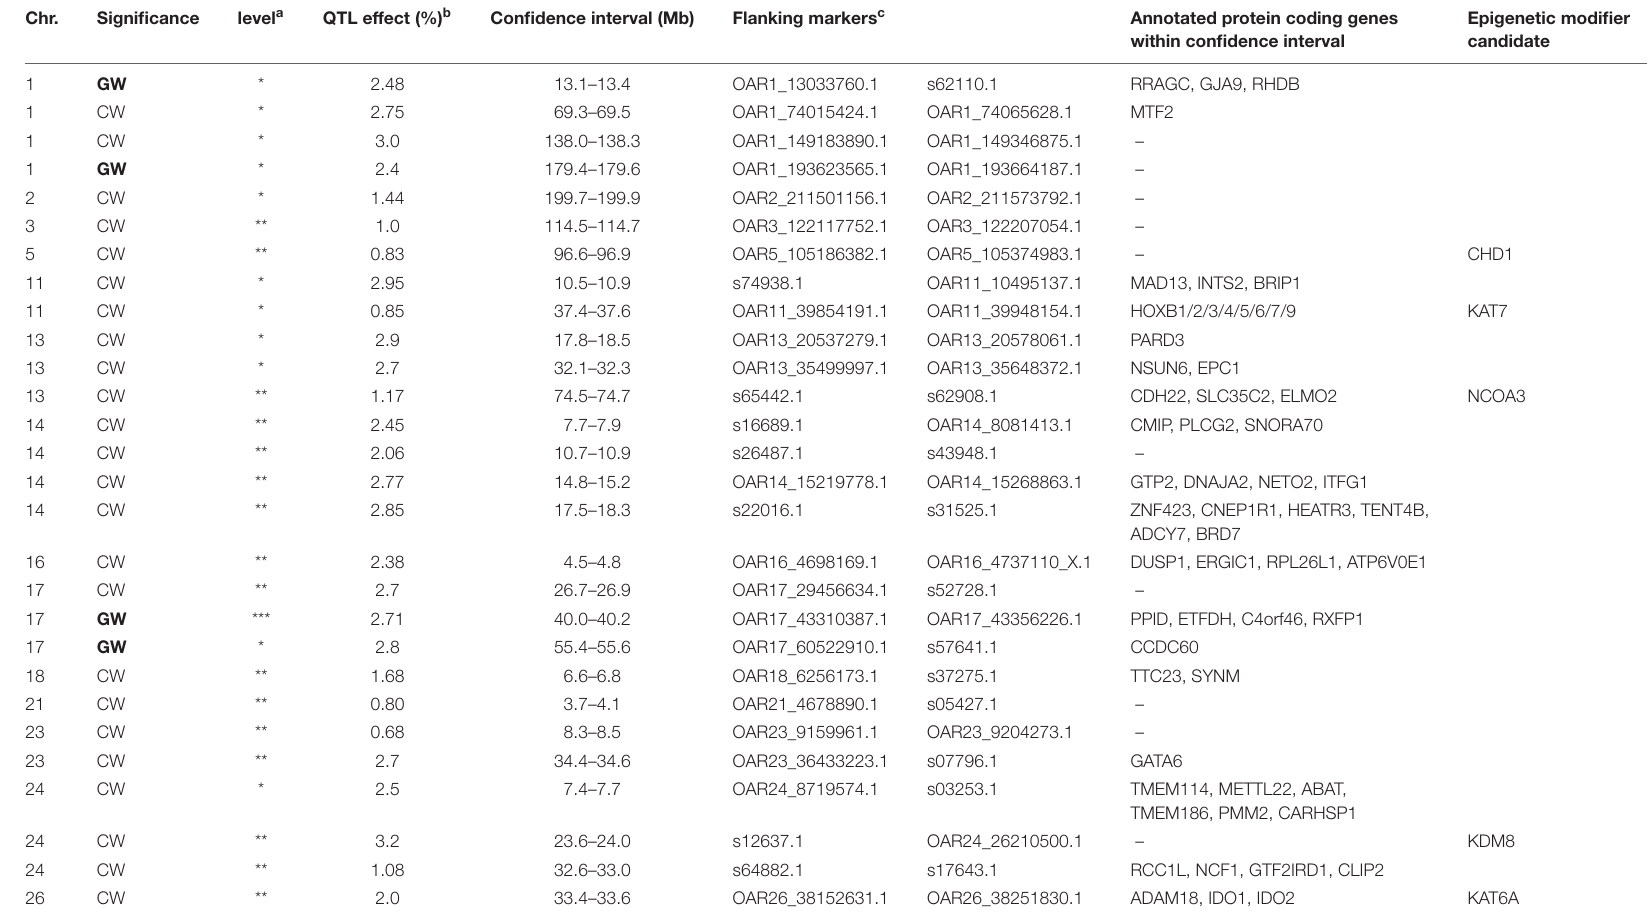
TABLE 4 | List of QTLs detected in joint analysis (linkage disequilibrium linkage analysis) associated with the global DNA methylation rate.